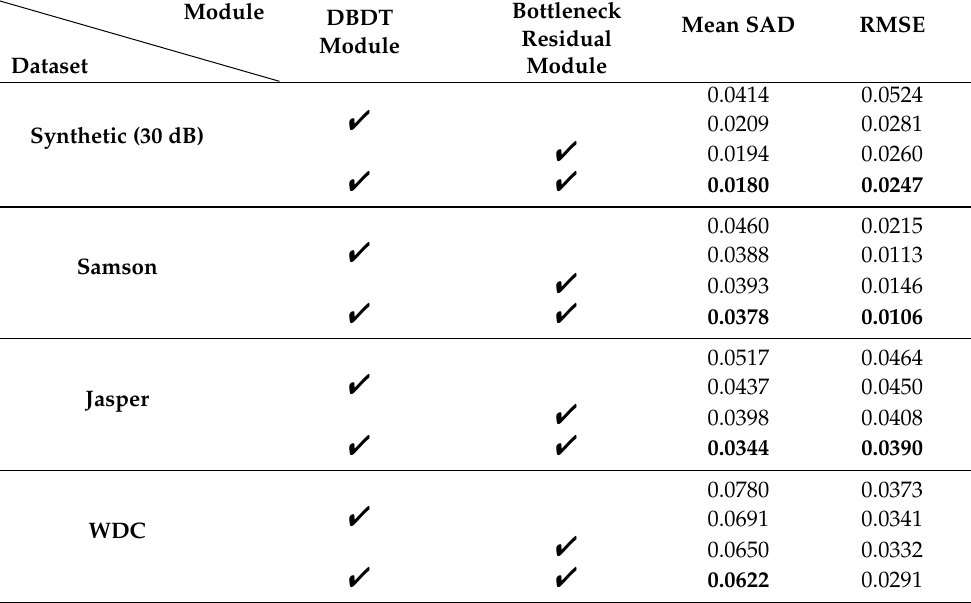
Table 7. Ablation study on evaluating the contribution of dilated convolution and residual modules in SPCN. The best results are shown in